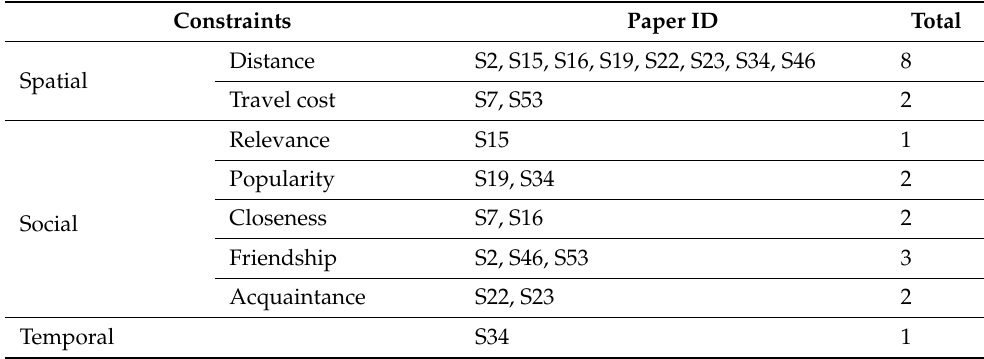
Table 15. Main types of spatial, social, and temporal constraints applied in geosocial nearest neighbor